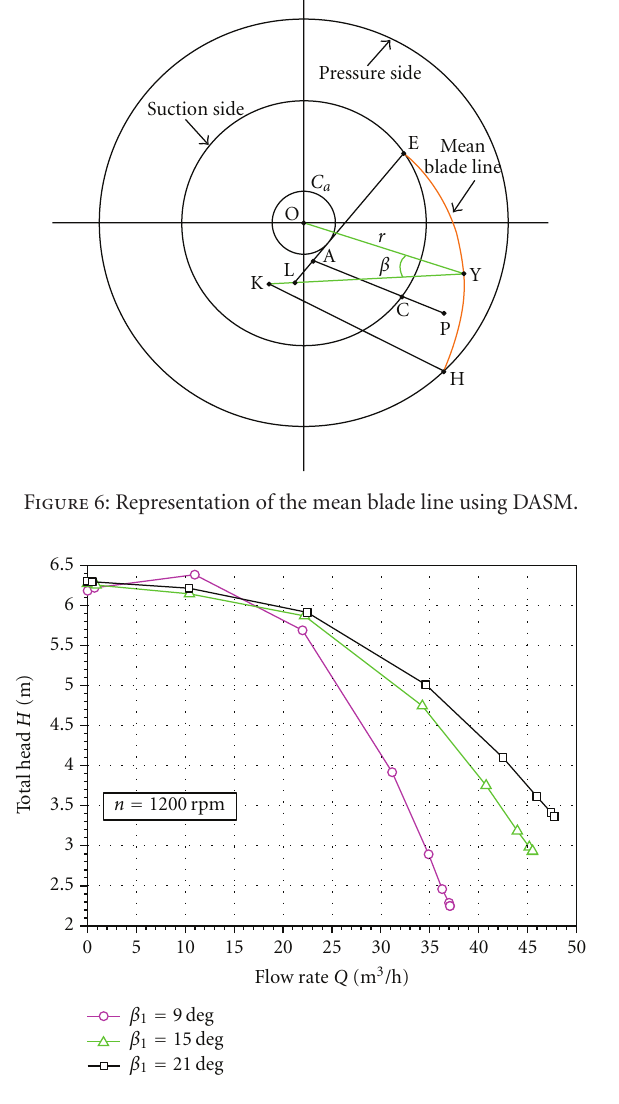
Figure 7: The total head as a function of the flow rate, studying the noncavitating performance.